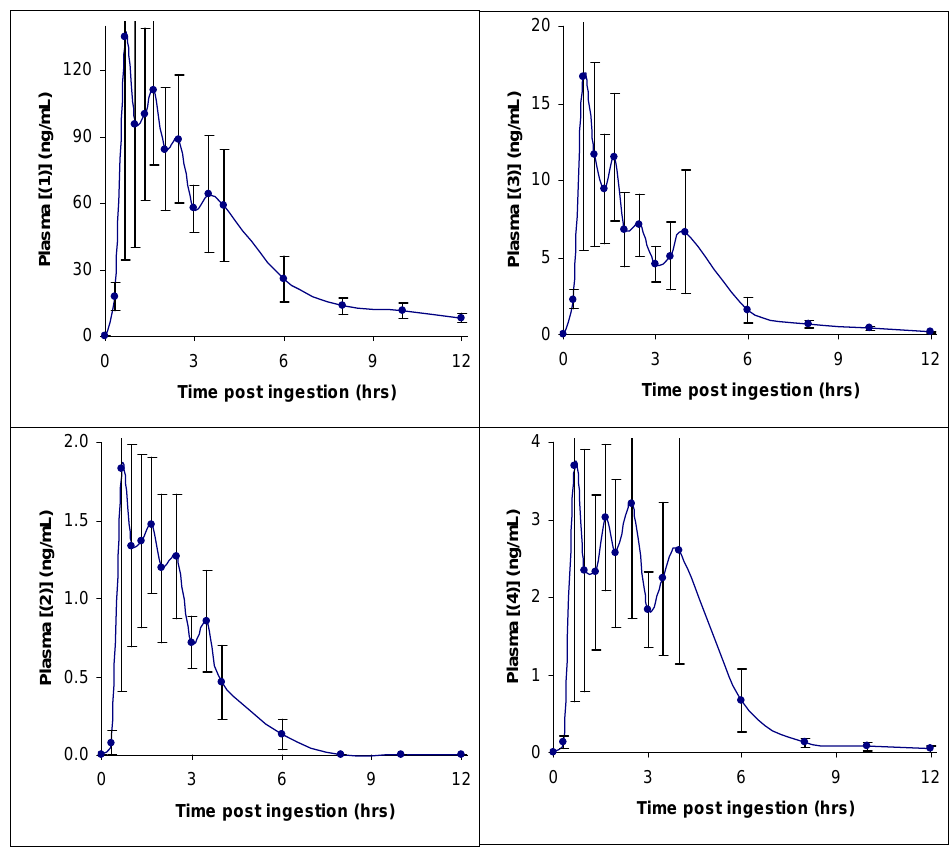
Figure 7: Human plasma alkylamide concentration time curves for compounds 1-4 . Values are means ± se for 9